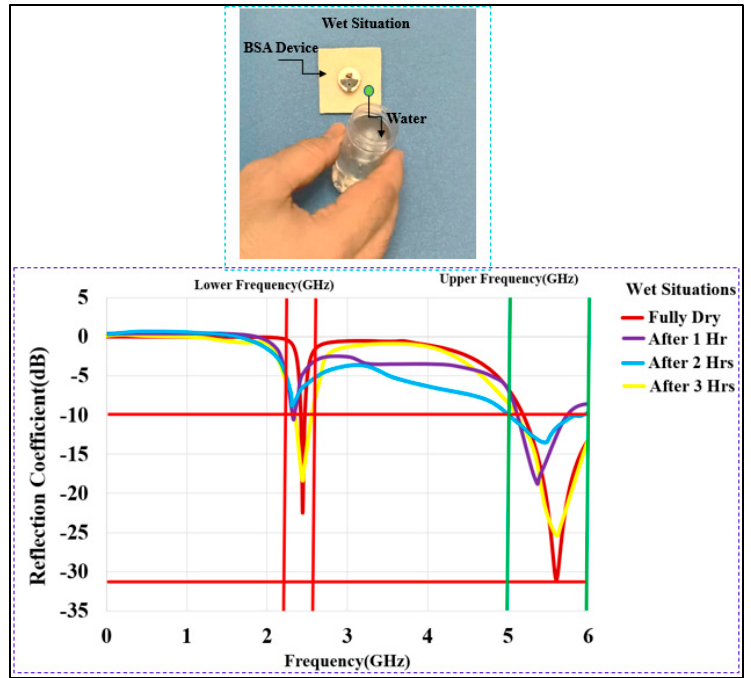
Figure 21. Measured S 11 of the BSA in wet situations (dry, after 1 h (1 Hr), 2 h (2 Hrs), and 3 h (3 Hrs)).